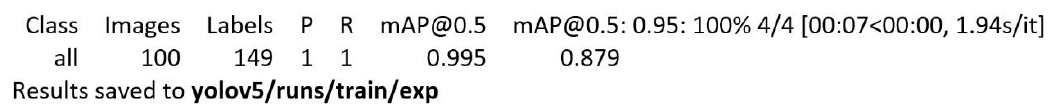
Sensors 2022 , 22 , x FOR PEER REVIEW Figure 14. YOLOv5 network training parameters of naval mines for submarines. Figure 14. YOLOv5 network training parameters of naval mines for submarines. Figure 14. YOLOv5 network training parameters of naval mines for submarines.